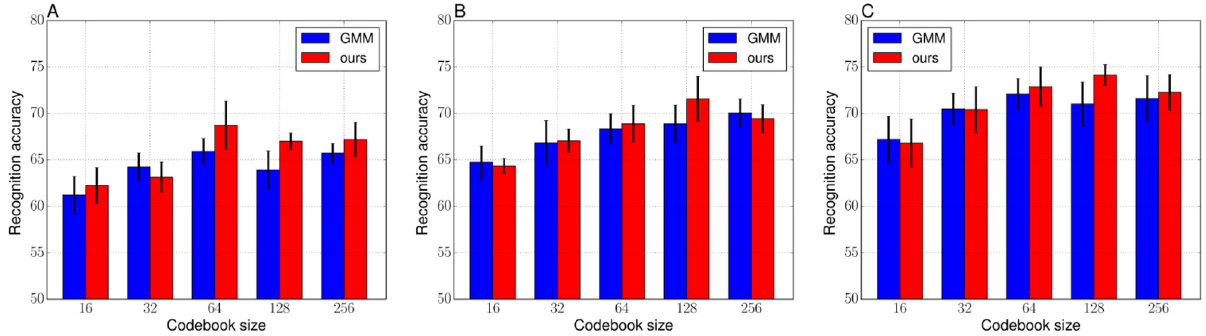
Fig 5. Recognition accuracies of the FVs with the GMM and ours (soft objective) codebooks on the Birds. (A) 30 images per category for training. (B) 40 images per category for training. (C) 50 images per category for training. https://doi.org/10.1371/journal.pone.0210146.g005 Table 4. Recognition performance (mean accuracy ± standard deviation) of the VLADs with the k-means and ours (hard objective) codebooks on the Birds, corre- sponding to the Fig 4. Codebook size